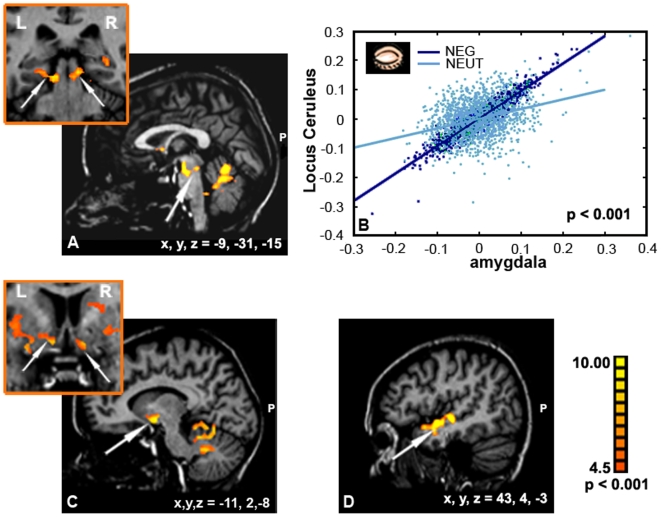
Correlation analysis for the amygdala ROI.An additional network of co-activation was revealed as during closed eyes in negative music. Arrows point to main regions of correlated activity with the ROI: (A) LC, (C) NAcc, and (D) anterior temporal gyrus. (B) Co-activation respectively to the emotional context is depicted. The correlated activity between the amygdala and LC during eyes closed was much stronger in the negative emotional condition than in the neutral condition.